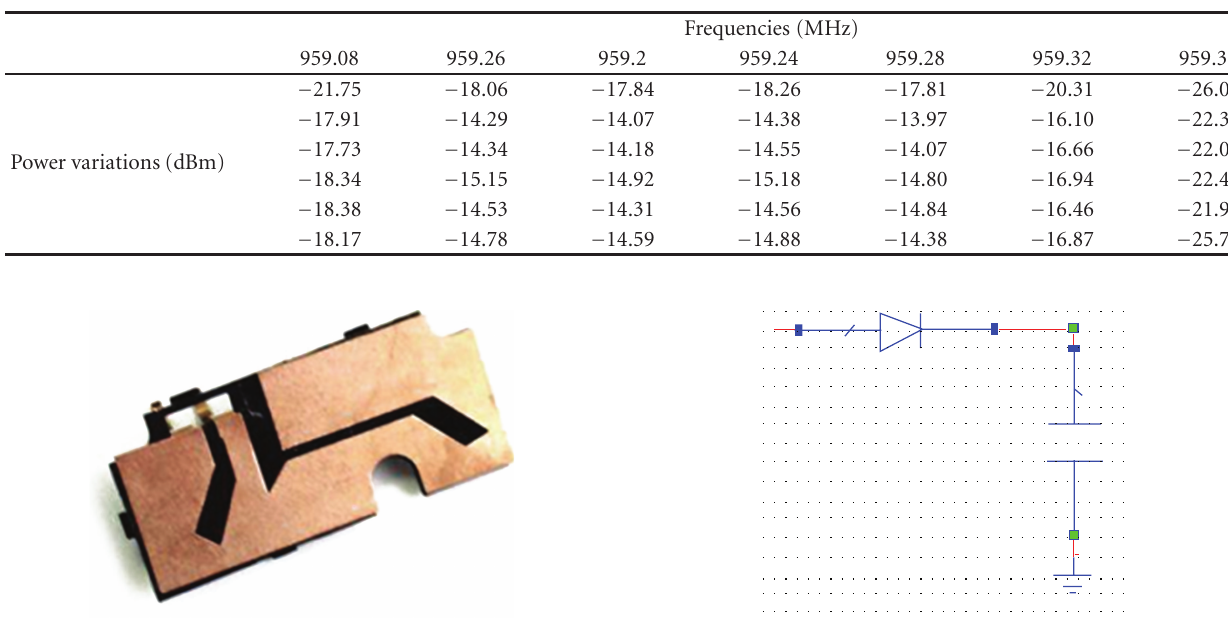
Figure 7: Passive peak